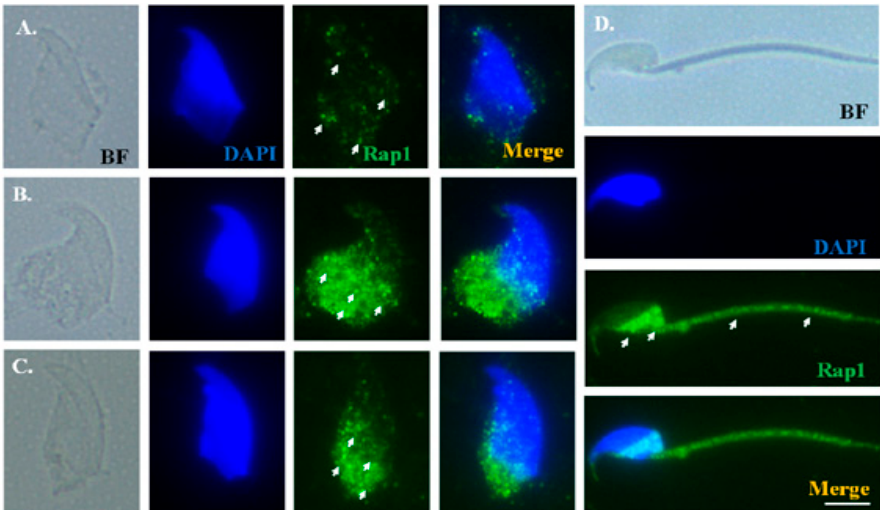
Figure 4. Rap1 signals showed multiple localizations during murine spermiogenesis. From left to right: bright field (BF), DAPI staining (blue), and Rap1 signal (green), as well as the merging of Rap1 and DAPI at early elongation ( A ), late elongation ( B ), early elongated spermatids ( C ), and mature sperm ( D ). Arrows indicate Rap1 signals. Scale bar: 5 μ m.